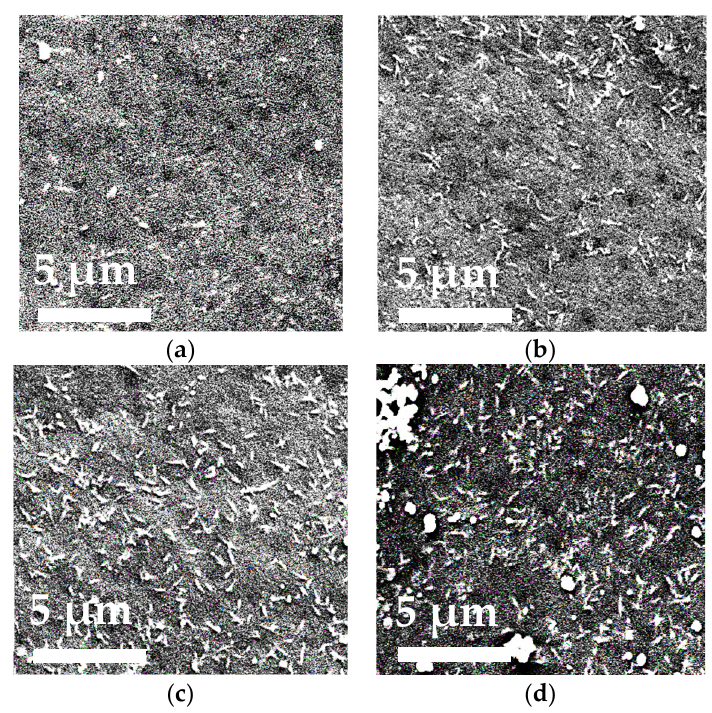
Figure 5. SEM images of the surface of the selective layer of membranes based on PA ( a ) and PA/TiO 2 (0.3 ( b ), 0.5 ( c ), and 0.75 ( d ) wt.%) composites.